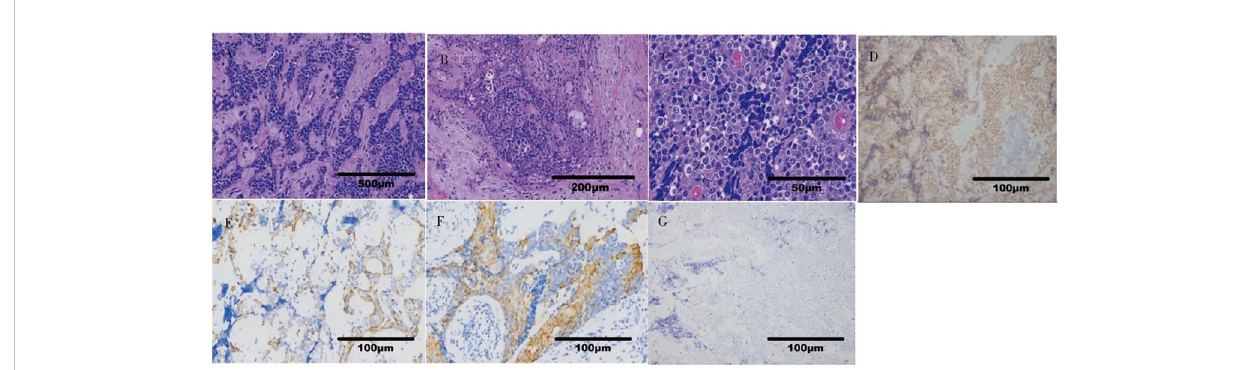
FIGURE 1 Histopathological fi ndings of NUT carcinoma. (A) The tumor cells were distributed in nests (x40). (B) The structure was similar to that of lymphoepitheliomatoid carcinoma (x100). (C) The tumor cells had large nuclei, abnormal karyotypes, some nucleoli and occasional mitotic fi gures (x400). (D) NUT(+) (x200). (E) AE1/AE3 (partial+) (x200). (F) Squamous tumor cells EMA (partial+) (x200). (G) F1i-1 (individual+)